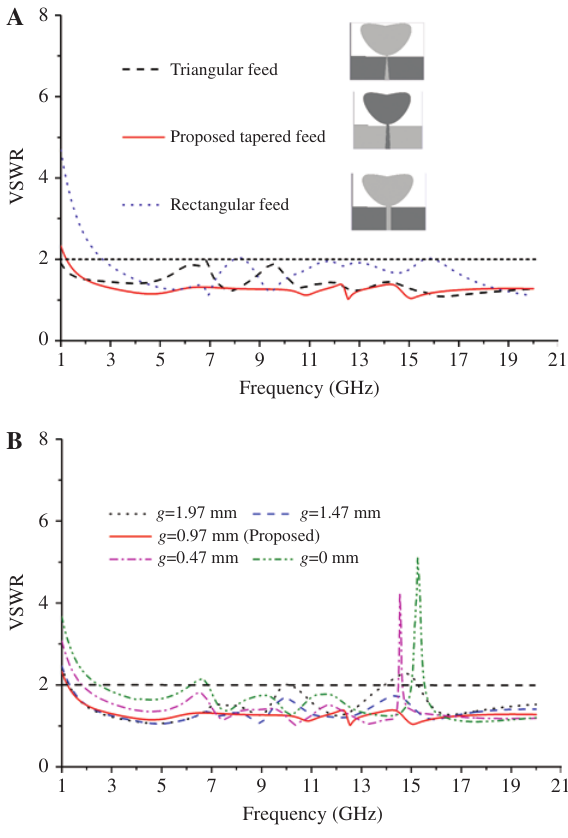
Figure 3: Effects of (A) varying feed shapes. (B) Gap g other param- eters are fixed.